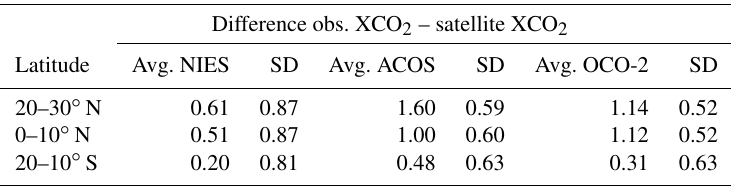
Figure 6. Latitudinal gradients of obs. XCO 2 (red) in comparison with the satellite XCO 2 from NIES (black), ACOS (gray), and OCO- 2 (blue) (a, b, c) , and the difference between the obs. XCO 2 and NIES (black), ACOS (red), and OCO-2 (blue) (d, e, f) for three selected months, March (a, d) , June (b, e) , and October (c, f) , in 2015. Red-shaded areas are the uncertainty of the obs. XCO 2 which was derived from the ± 2ppm variability in the observation-based CO 2 profile at ∼ 850hPa. Error bars show the standard deviation of the monthly averaged XCO 2 and of the location within each latitude box. Table 3. Average (avg.) difference and the standard deviation (SD) between obs. and satellite XCO 2 from GOSAT (NIES, ACOS) and OCO-2 of each latitude range between 2014 and